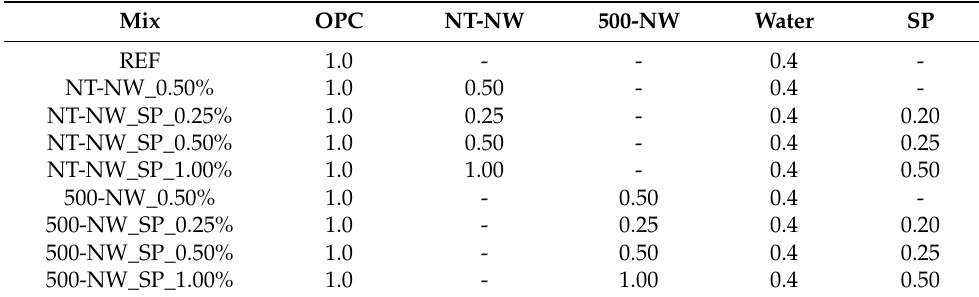
Table 1. Detailed composition of the pastes investigated (by weight).